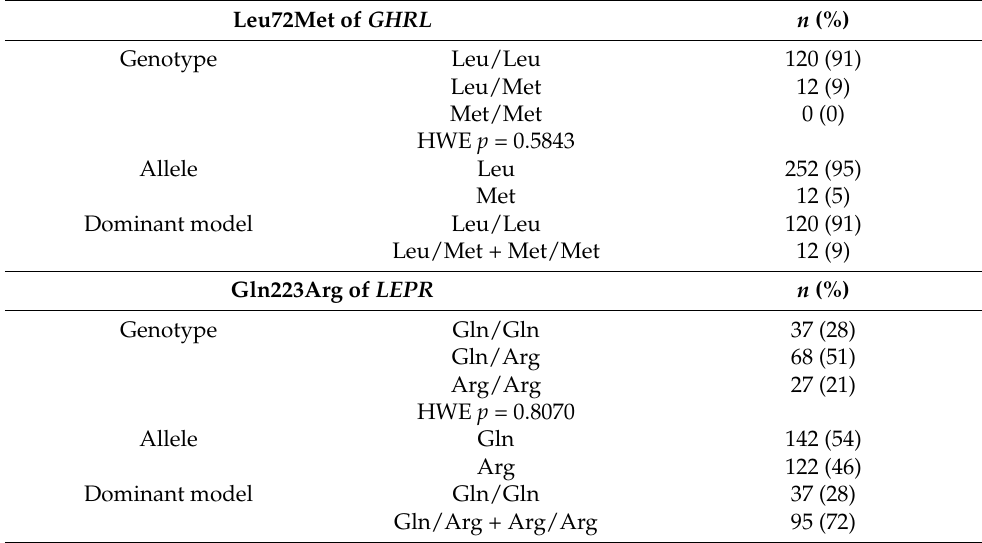
Table 2. Genotype and allelic frequencies of Leu72Met of GHRL and Gln223Arg of LEPR .